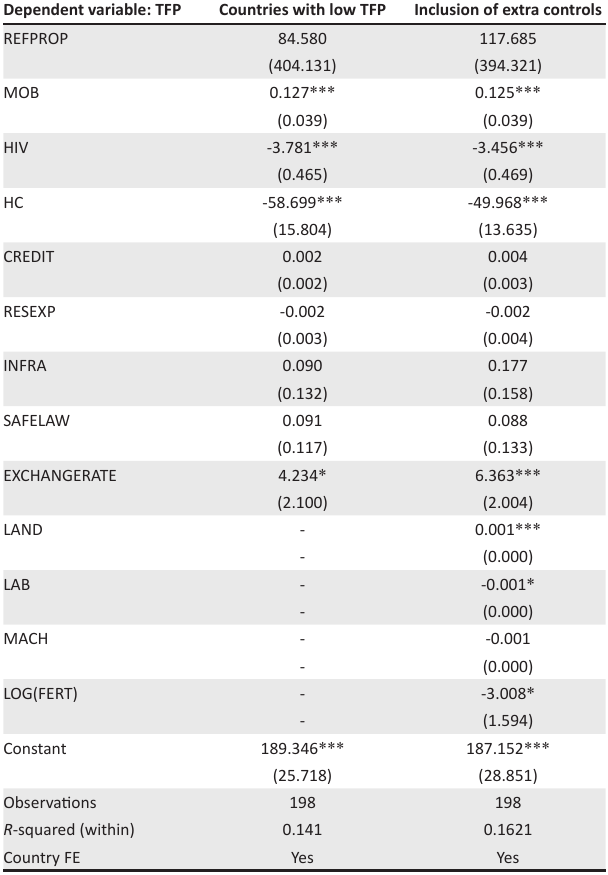
TABLE 7: Accounting for countries with low total factor productivity (TFP), and inclusion of additional control variables. Dependent variable: TFP Countries with low TFP Inclusion of extra controls